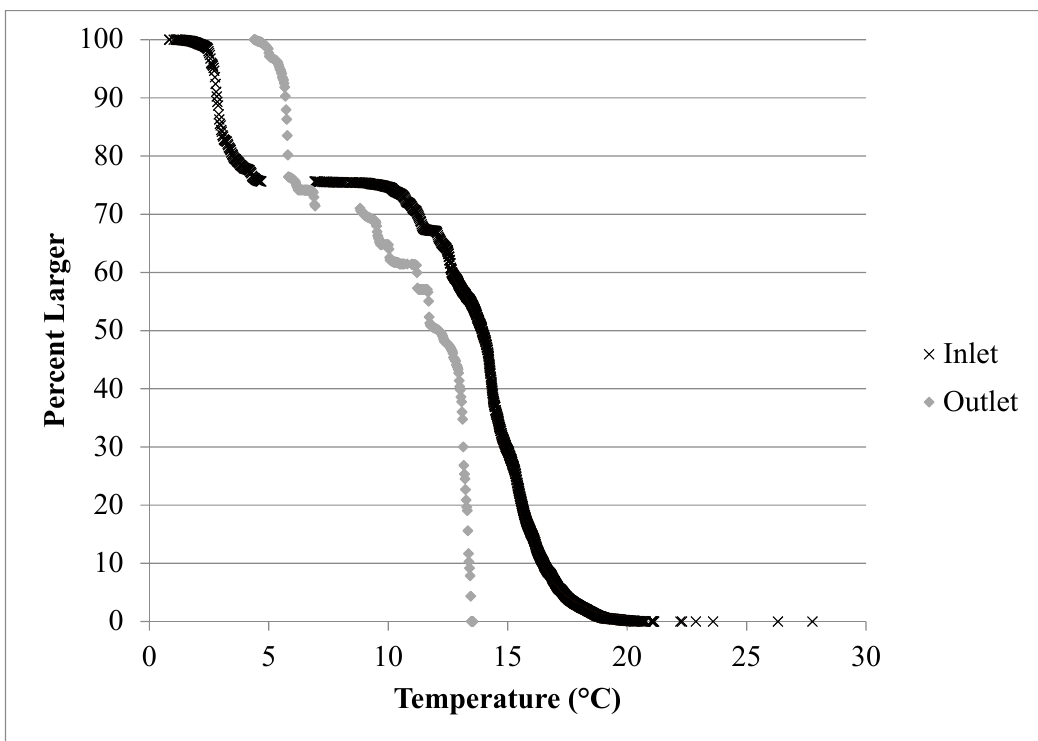
Figure 4. Probability plot of inlet and outlet water temperature over the entire monitoring period.